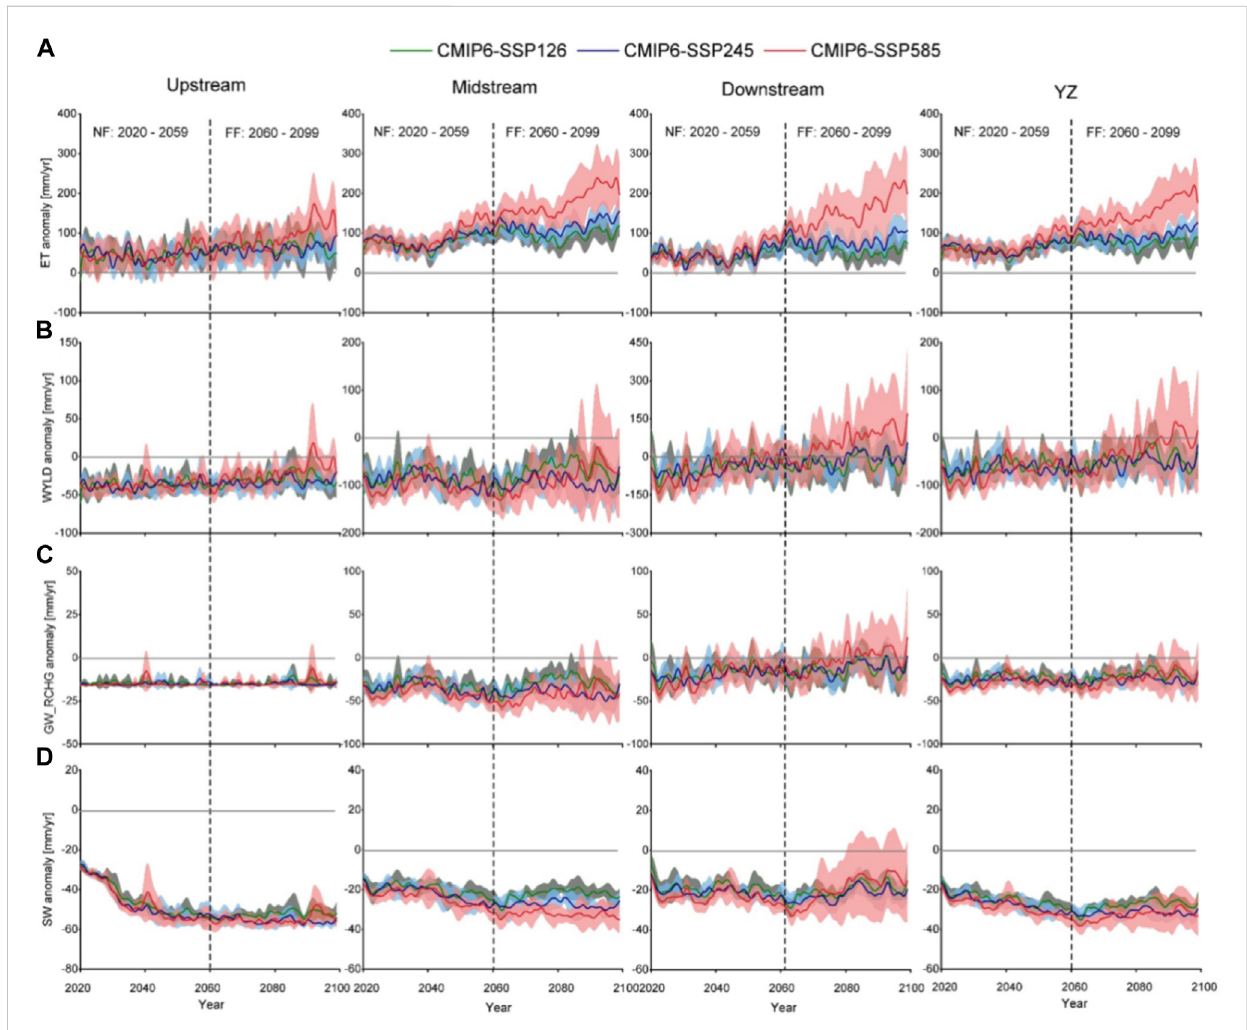
FIGURE 10 The anomalous statistics from the historical multi-year average of (A) evaporation (ET), (B) water yield (WYLD), (C) groundwater recharge (GW_ RCHG), and (D) soil water content (SW) in the upstream, midstream, downstream and YZB in the near future (NF: 2020 – 2059) and far future (FF: 2060 – 2099), under three different scenarios of CMIP6 (SSP126, SSP245, SSP585).